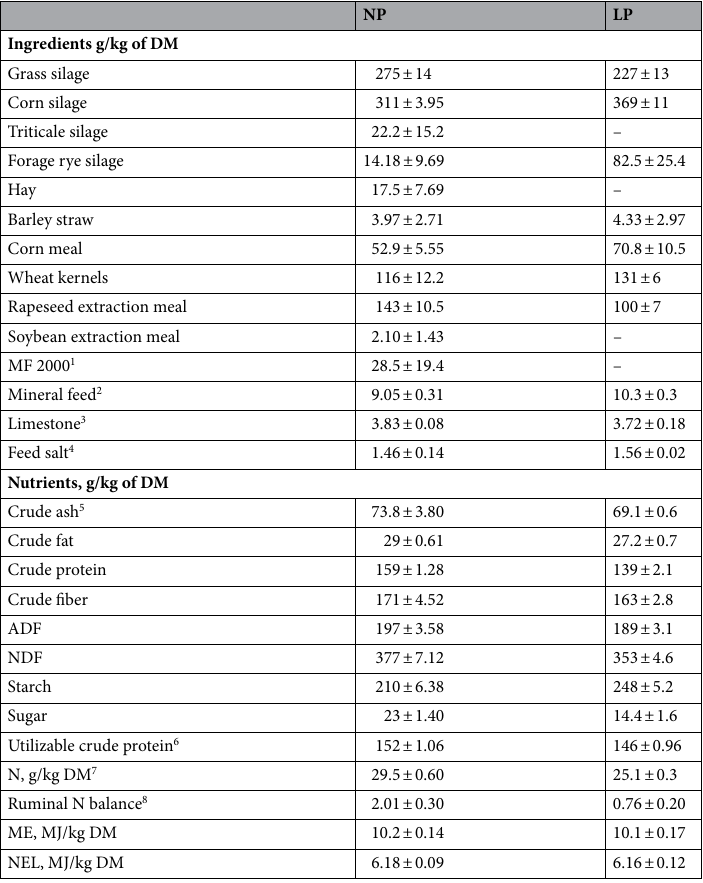
Table 1. Feed constitutes, nutrient composition and energy concentration of the normal protein (NP) and low protein (LP) diets (means ± SEM). 1 MF2000 pell. (Ceravis Produktion und Transport GmbH, Malchin, Germany): 24% crude protein, 2.6% crude fat, 5.10% crude fiber, 8% crude ash, 0.73% calcium, 0.5% phosphorus, 0.65% sodium, 7.1 MJ NEL/kg; Additives: 10,000 I.E. vitamin A, 1125 I.E. vitamin D3, 40